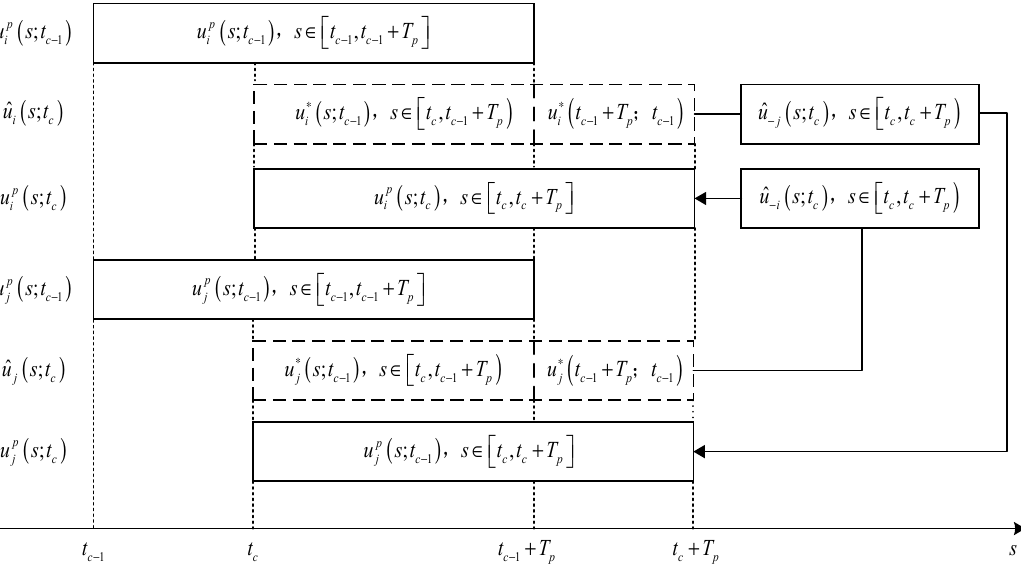
Figure 5. Solution process of the predicted state value.